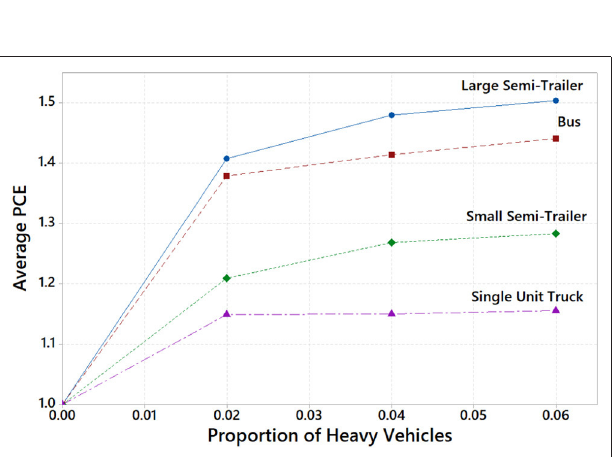
FIGURE 2 | Three volume scenarios: balanced, unbalanced, congested (Kinzel and Trueblood, 2004).